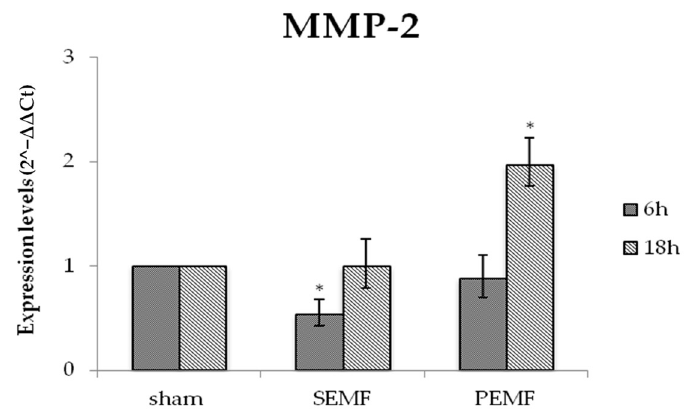
Figure 6. The mRNA expression of metalloproteinase 2 (MMP-2) in hGFs exposed to the SEMF and the PEMF compared to sham-exposed cells. MMP-2 expression levels (2 −ΔΔ C t ) are reported as mean ± standard error (SE). * p -Value < 0.05 SEMF or PEMF vs. sham assumed as 1.